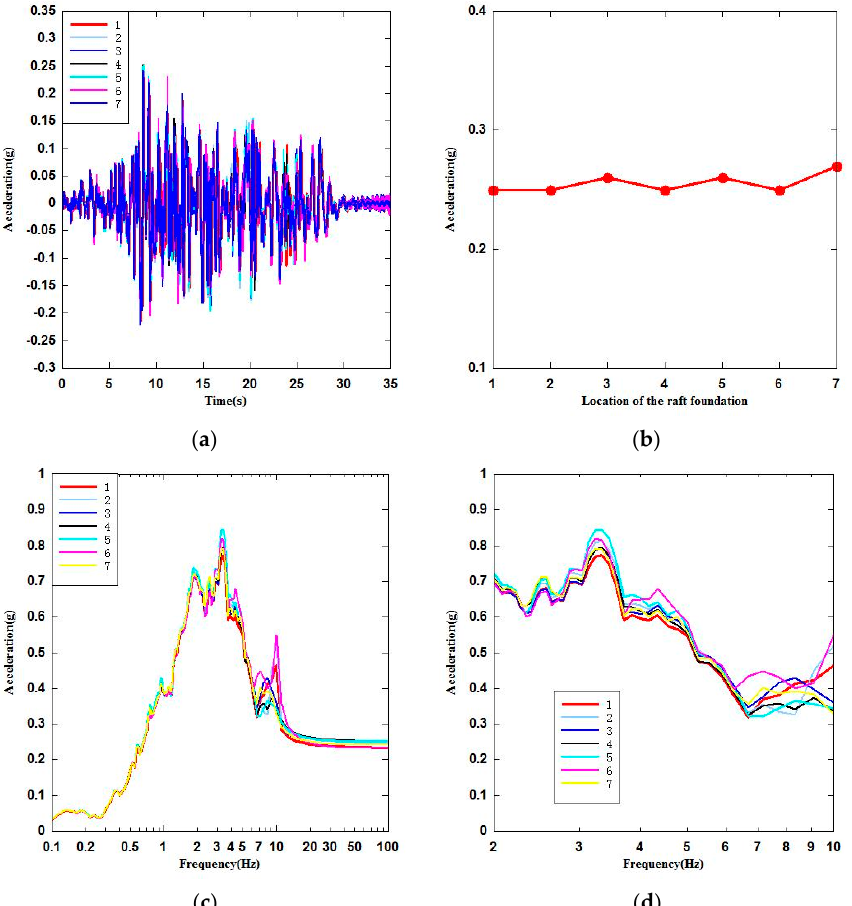
Figure 12. Peak acceleration and floor response spectrum of the raft foundation at 7 positions in the x direction. ( a ) Acceleration time history of the raft foundation in the x direction. ( b ) Peak acceleration of the raft foundation in the x direction. ( c ) Floor response spectrum of the raft foundation in the x direction. ( d ) Floor response spectrum of the raft foundation in the x direction (2–10 Hz).